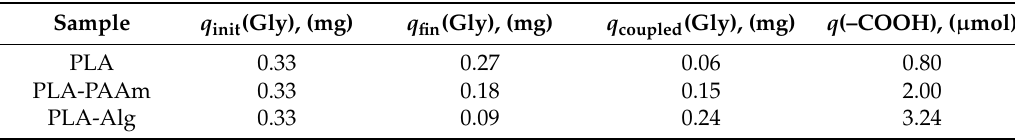
Table 3. Quantity of glycine coupled to the initial and modified films.